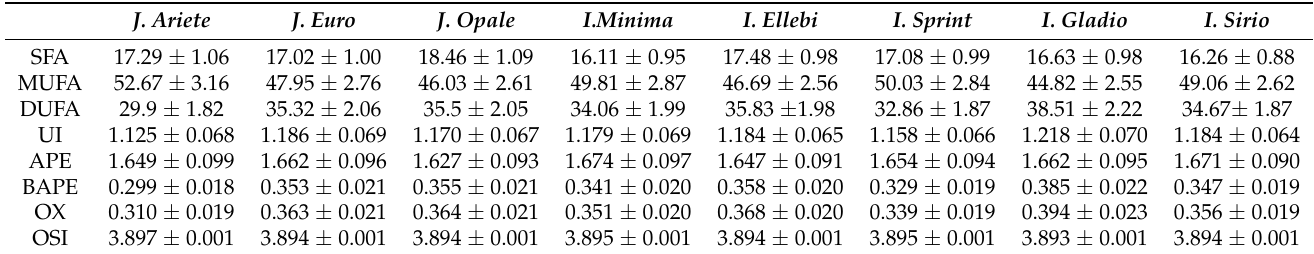
Table 4. Main fatty acid groups. SFA, MUFA, and DUFA composition of bran oils obtained from 8 rice varieties japonica and indica, from Portugal, obtained at 40 MPa, 313 K, and flow rate of 1.0 L/min. Calculated unsaturation index, UI and OX, APE, BAPE, and